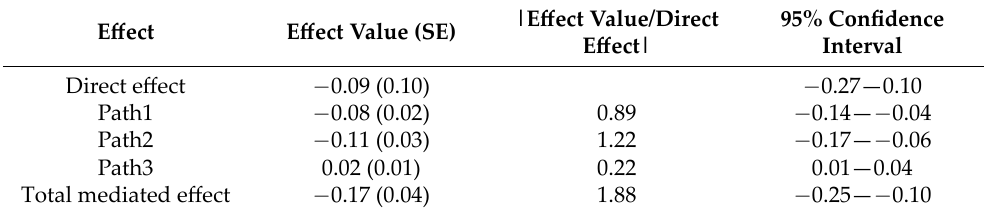
Table 3. Direct and mediated effects between parental rejection to learning